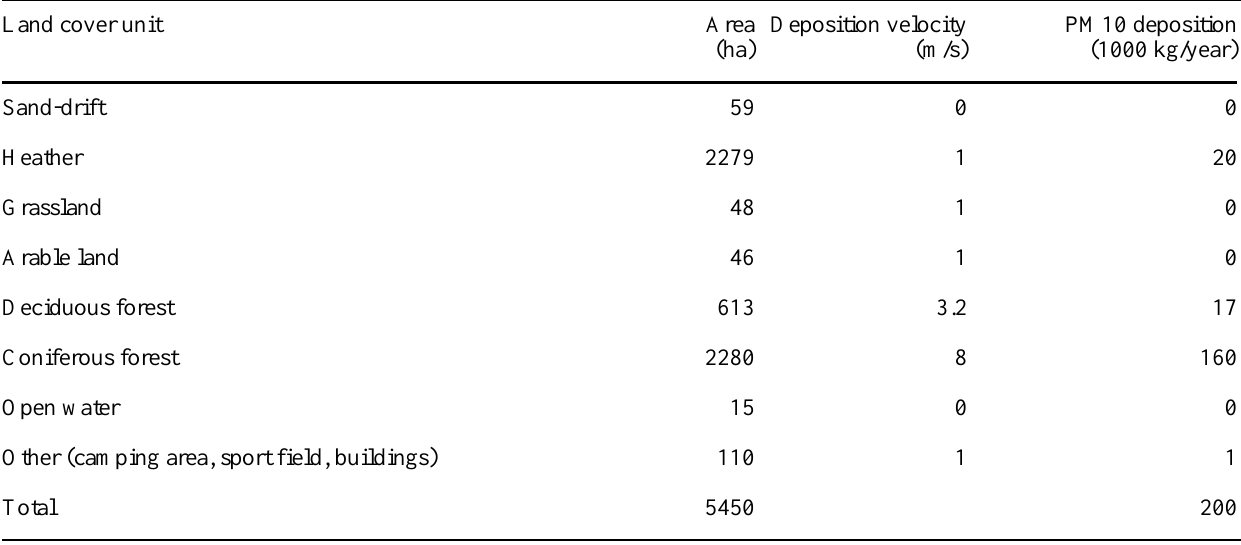
Table 2 . PM10 deposition in the Hoge Veluwe park Land cover